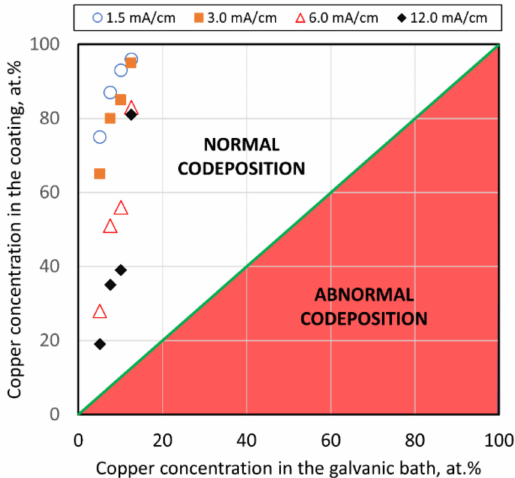
Figure 10. Graphical presentation of the influence of the galvanic bath composition and current density on the type of codeposition according to Brenner’s classification (green line refers to regular